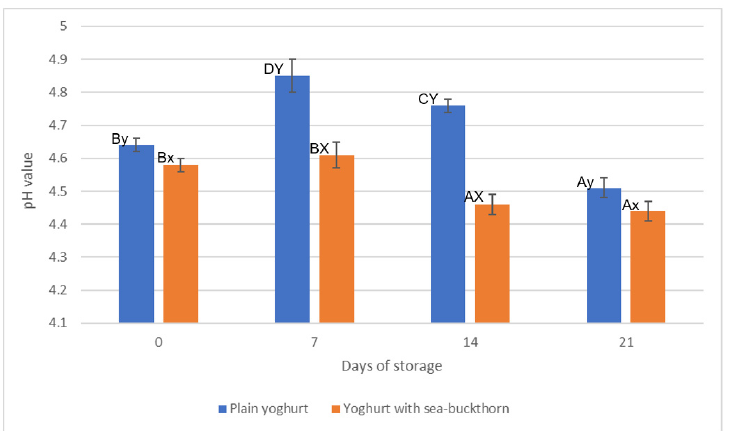
Figure 1. Changes of pH value in the analysed yoghurts during 21 days of storage in the refrigerated conditions. A, B, C, D—differences between the pH value within a yoghurt type, significant at p ≤ 0.01. x, y, X, Y—differences between days of storage regardless of yoghurt type; x, y—significant differences at p ≤ 0.05; X, Y—significant differences at p ≤ 0.01.